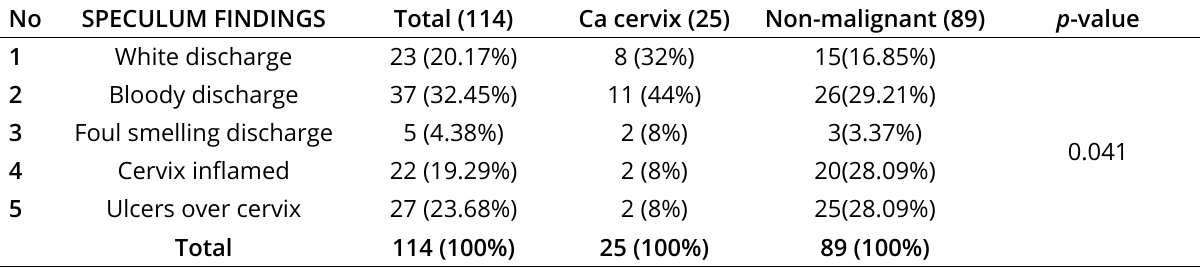
Table 2. Genital examination findings.